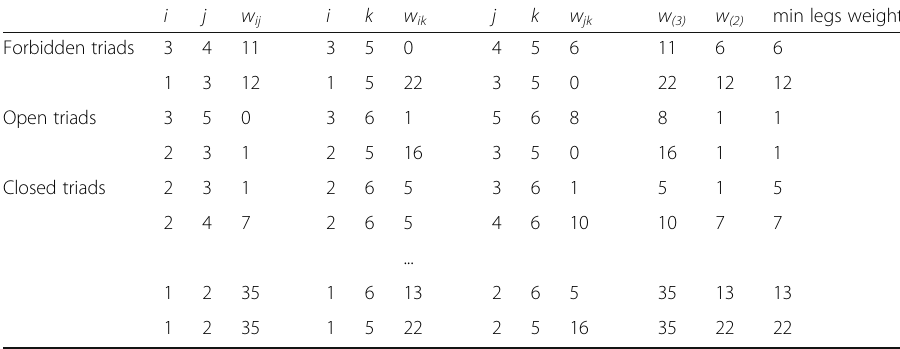
Table 2 Triad types in the example session of “ Kind of Blue ” , March 2,